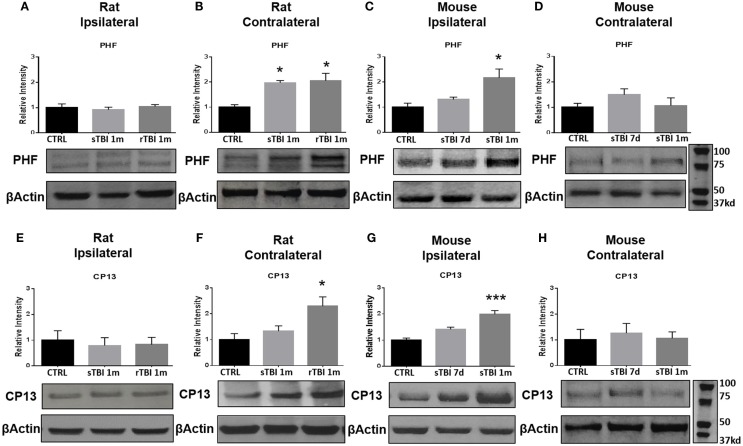
Blast and closed-head injury models both induce conformational changes in tau proteins. (A) Immunoblots show no significant difference in markers of tau conformational change at serine site 396/404 (PHF) at 1 month after single and repeat blast exposure in the ipsilateral rat hippocampus. (B) A significant increase in PHF expression was measured after single (*p < 0.05 vs. CTRL) and repeat blast exposure (*p < 0.05 vs. CTRL) in the contralateral rat hippocampus. (C) PHF expression was significantly increased at 1 month after closed-head injury in the ipsilateral mouse hippocampus. (D) No significant differences were observed in PHF expression in the contralateral mouse hippocampus. (E) Immunoblots show no significant difference in markers of tau conformational change at serine site 202 (CP13) at 1 month after single and repeat blast exposure in the ipsilateral rat hippocampus. (F) A significant increase in CP13 expression was measured at 1 month after repeat blast exposure (*p < 0.05 vs. CTRL) in the contralateral rat hippocampus. (G) A significant increase in CP13 expression was measured at 1 month after closed-head injury in the ipsilateral mouse hippocampus (***p < 0.001 vs. CTRL). (H) No significant differences were observed in CP13 expression in the contralateral mouse hippocampus after closed-head injury. One-way ANOVA Tukey’s post hoc analysis (values represent mean ± SEM; normalized to β-actin) (n = 3–5).